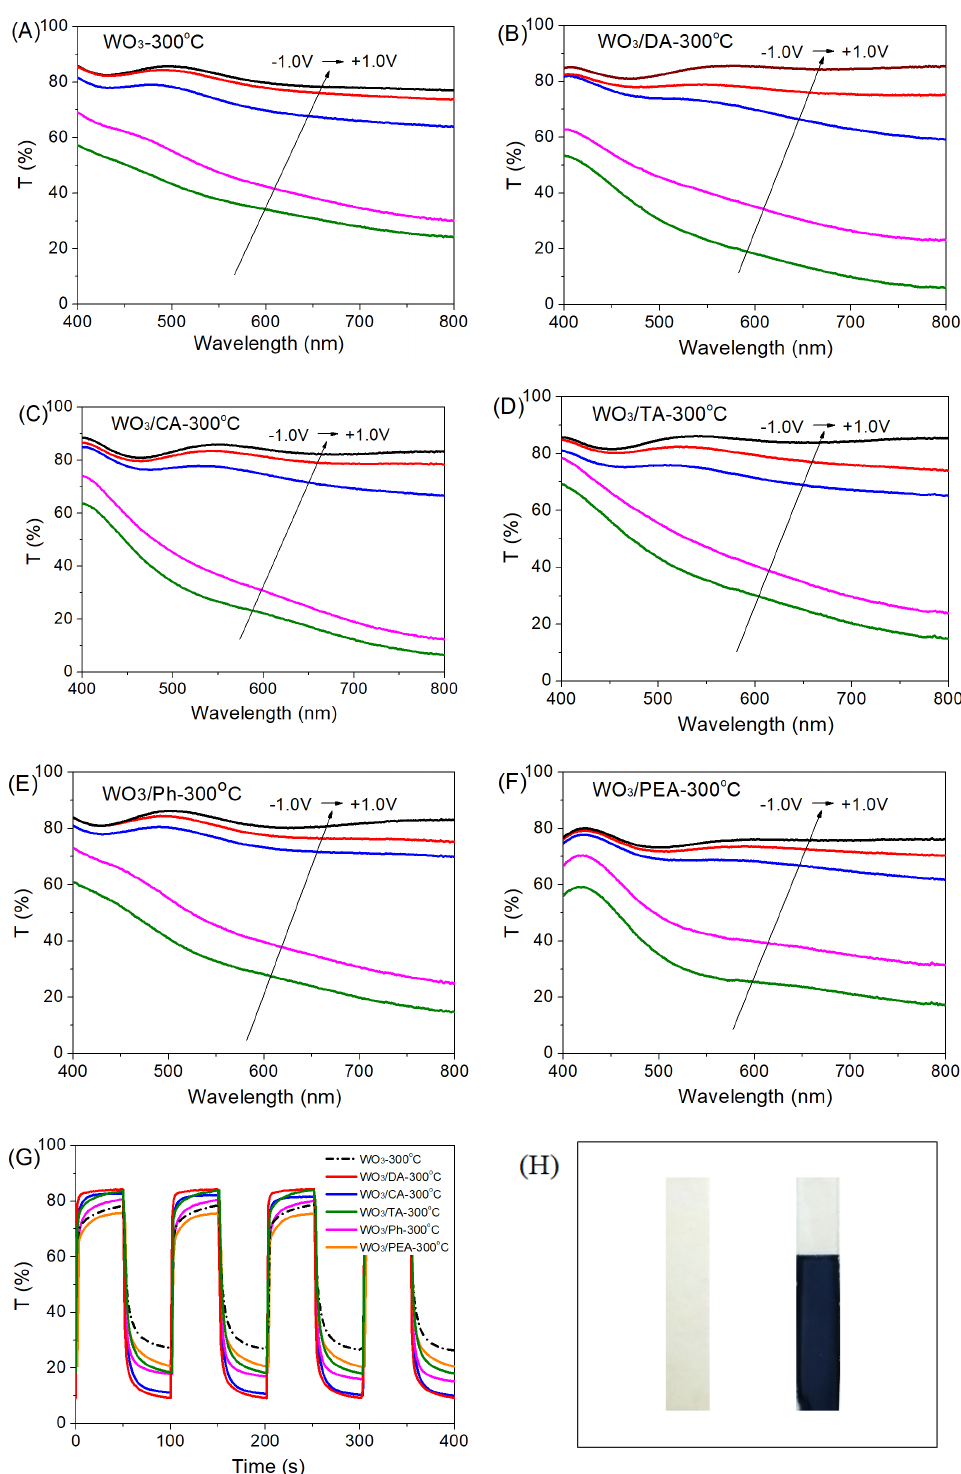
Figure 7. UV-vis transmittance spectra at different potentials of ( A ) pure WO 3 -300 ◦ C, ( B ) WO 3 /DA-300 ◦ C, ( C ) WO 3 /CA-300 ◦ C, ( D ) WO 3 /TA-300 ◦ C, ( E ) WO 3 /Ph-300 ◦ C, and ( F ) WO 3 /PEA-300 ◦ C films at the potentials of − 1.0, − 0.8, +0.5, +0.8 and +1.0 V, as shown in green, violet, blue, red and black lines, respectively, ( G ) switching curve comparison between the WO 3 -300 ◦ C, WO 3 /DA-300 ◦ C, WO 3 /CA-300 ◦ C, WO 3 /TA-300 ◦ C, WO 3 /Ph-300 ◦ C, and WO 3 /PEA-300 ◦ C films at λ 720nm (+1.0 V/ − 1.0 V, 100 s per cycle), and ( H ) the photo of the WO 3 /DA-300 ◦ C films in the bleached and colored states respectively.